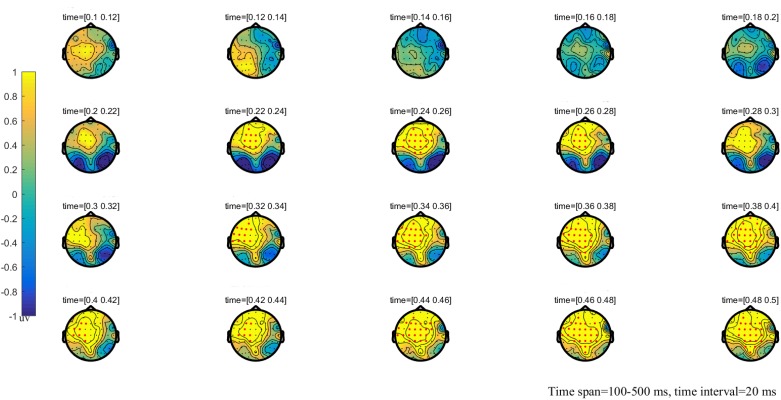
The global topographic map of the difference between NT and HT, time from 100 to 500 ms after stimulation onset. The results showed that the difference of waveform between the two stimuli is mainly reflected in the prefrontal area of 200–260 ms and the frontal-parietal and posterior area of 330–500 ms. Red points indicate that these electrodes are members of significant clusters.